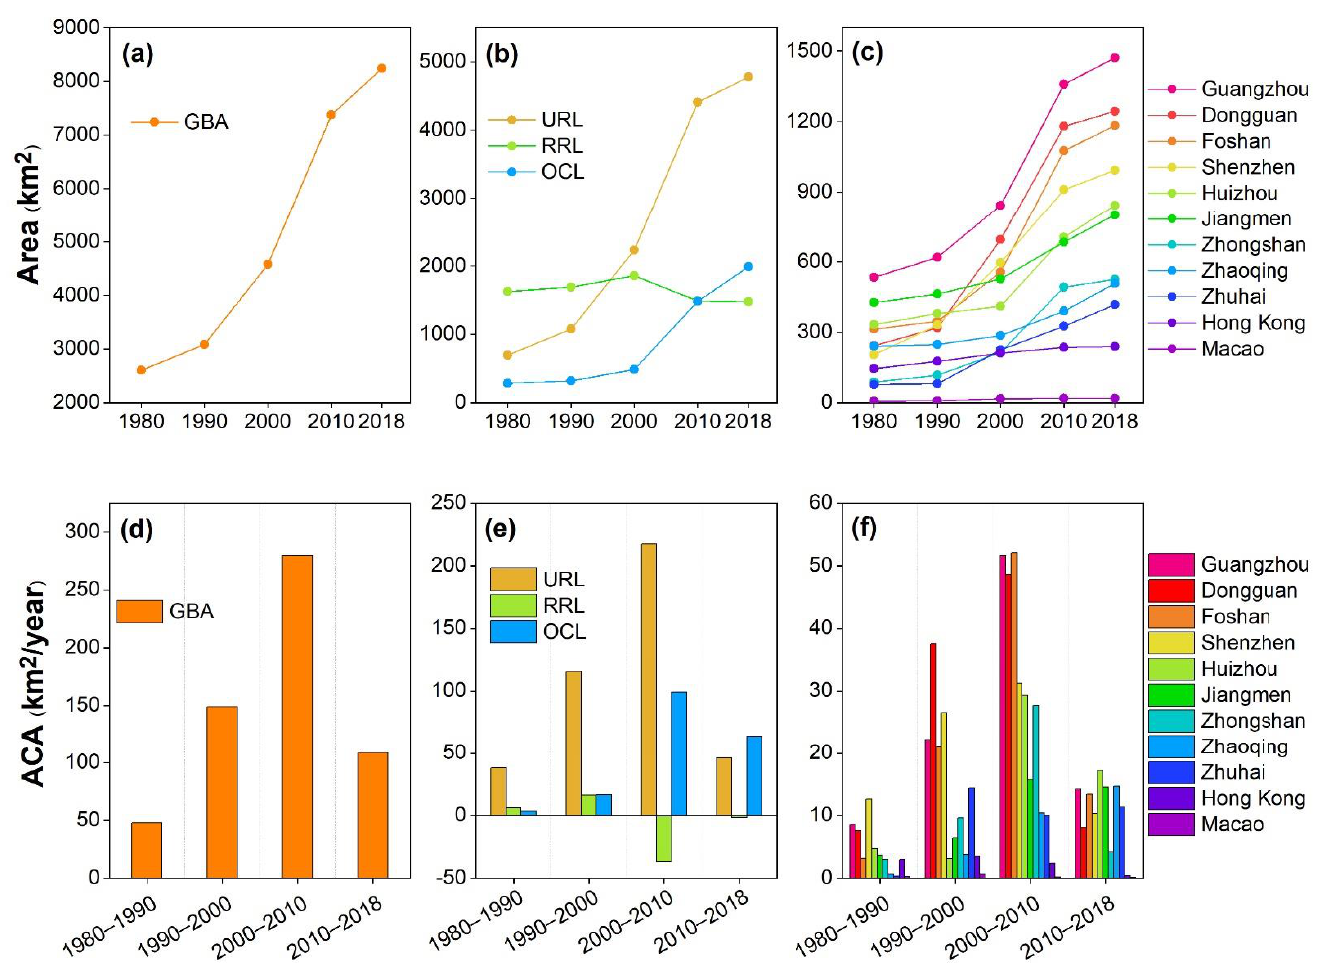
Figure 2. Construction land evolution of the GBA from 1980 to 2018: ( a – c ) are the growth of construction land for the total GBA, different types of construction land and 11 cities, respectively; ( d – f ) present the annual change area (ACA) of the construction land of the total GBA, different types and 11 cities, respectively. URL: urban residential land; RRL: rural residential land; OCL: other construction land.